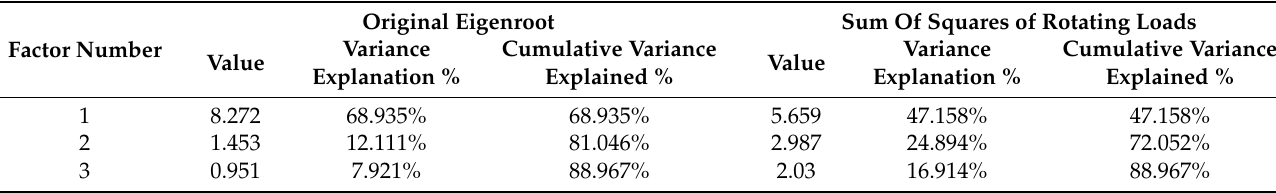
Table 7. Factor Analysis Variance Interpretation.